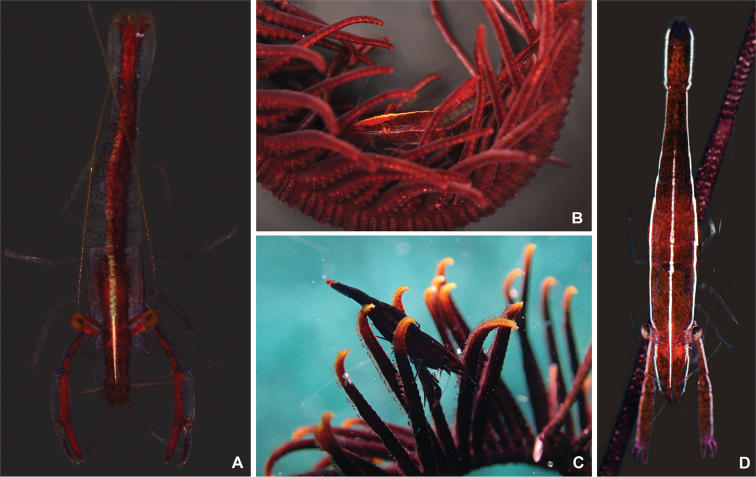
Colour pattern of three species of Cristimenes. ACristimenesbrucei sp. nov. from Korea (MADBK 120532_017) B same, with host crinoid species CCristimenescommensalis (Borradaile, 1915) from Vietnam (SNU VI VI305) DCristimenescristimanus (Bruce, 1965) from Vietnam (SNU VI VI297).